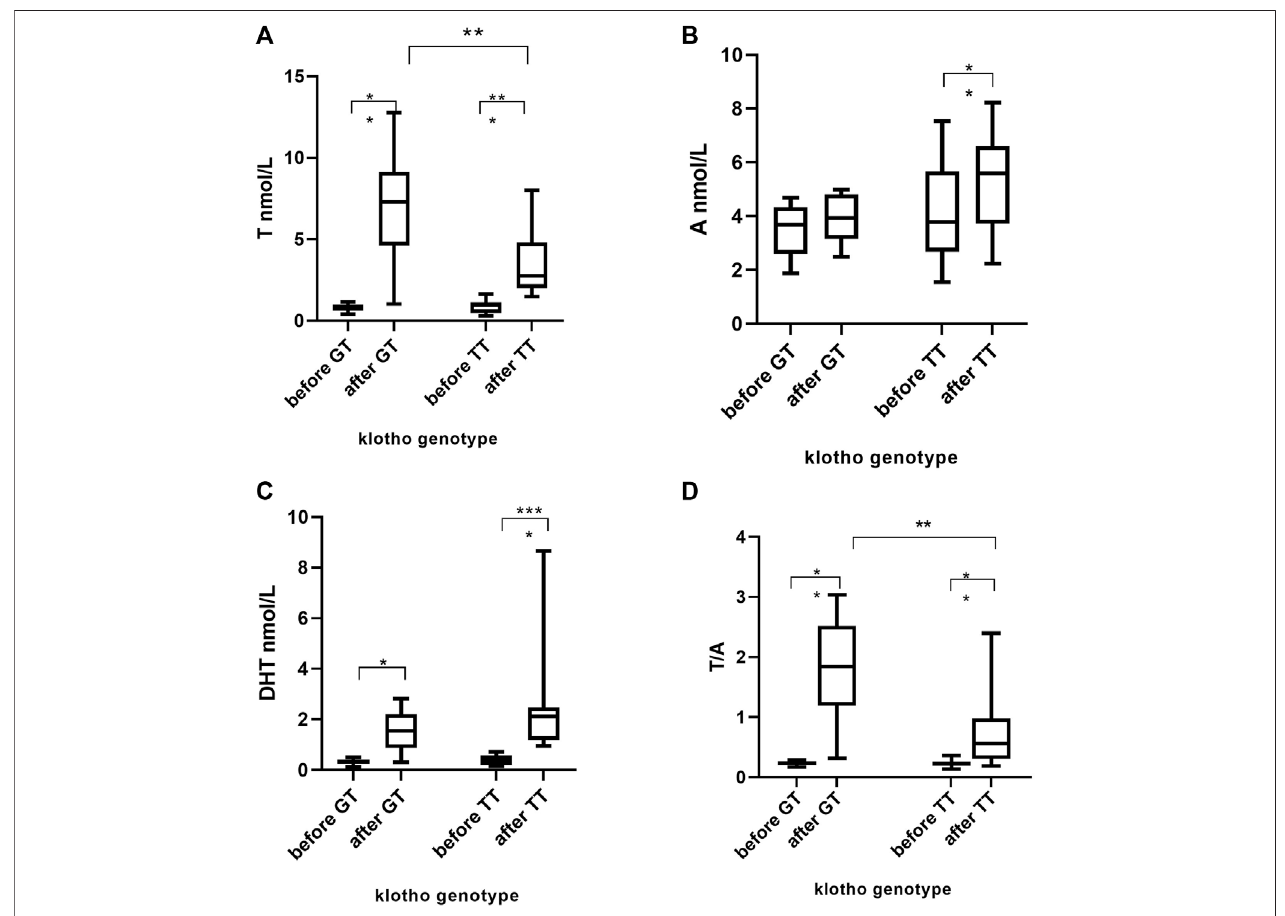
FIGURE 1 | Serum concentrations of T, A, DHT and T/A before and after 10 weeks daily administration of T in 22 women. T = testosterone, A = androstenedione, DHT = dihydrotestosterone. * p < 0.05, ** p < 0.01, *** p < 0.001, **** p < 0.0001.